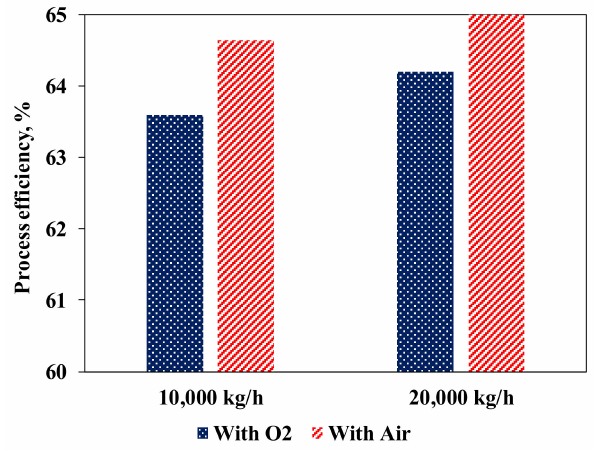
Figure 12. Overall process efficiencies for systems using air and systems using oxygen. ( left ) 10,000 kg/h PEFB plant, ( right ) 20,000 kg/h PEFB